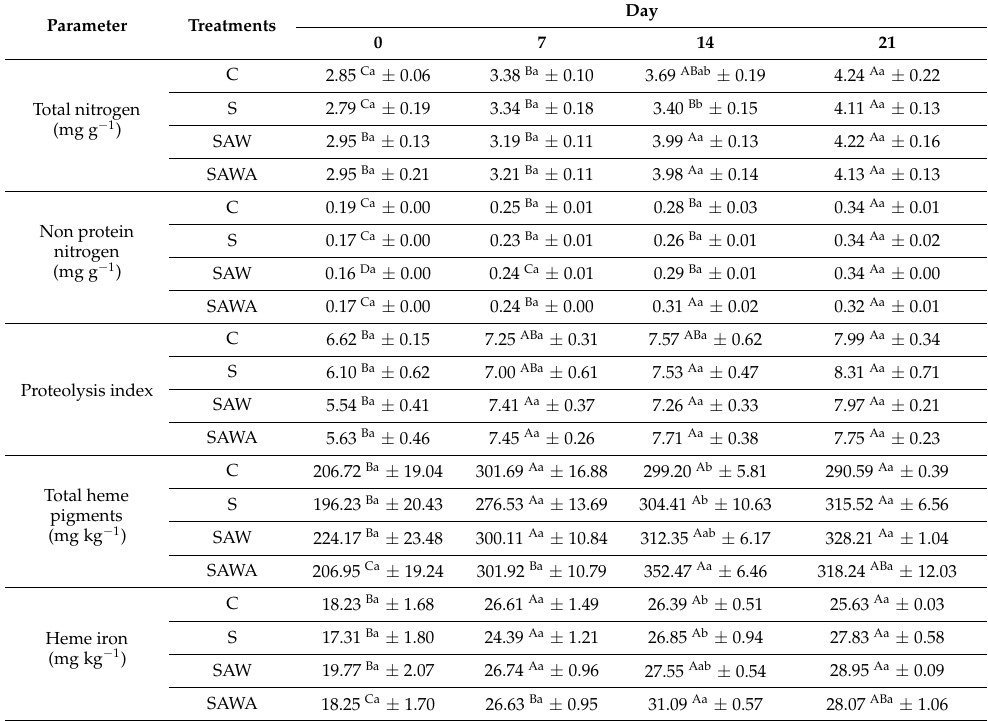
Table 3. Content of total and non-protein nitrogen, proteolysis index, total content of pigments and heme iron of dry fermented sausages during processing (mean ± SD).